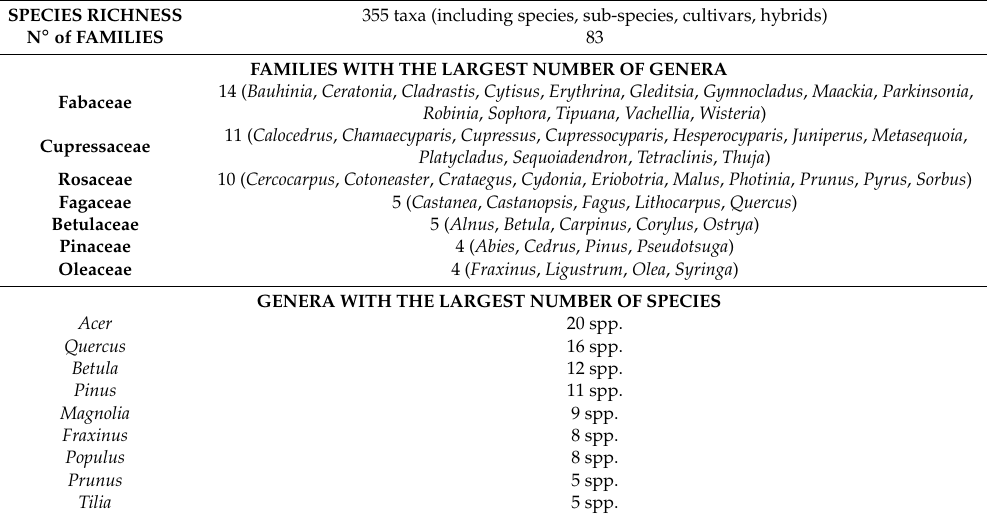
Table 1. Results from the inventories of trees carried out in the Mediterranean parks considered in this